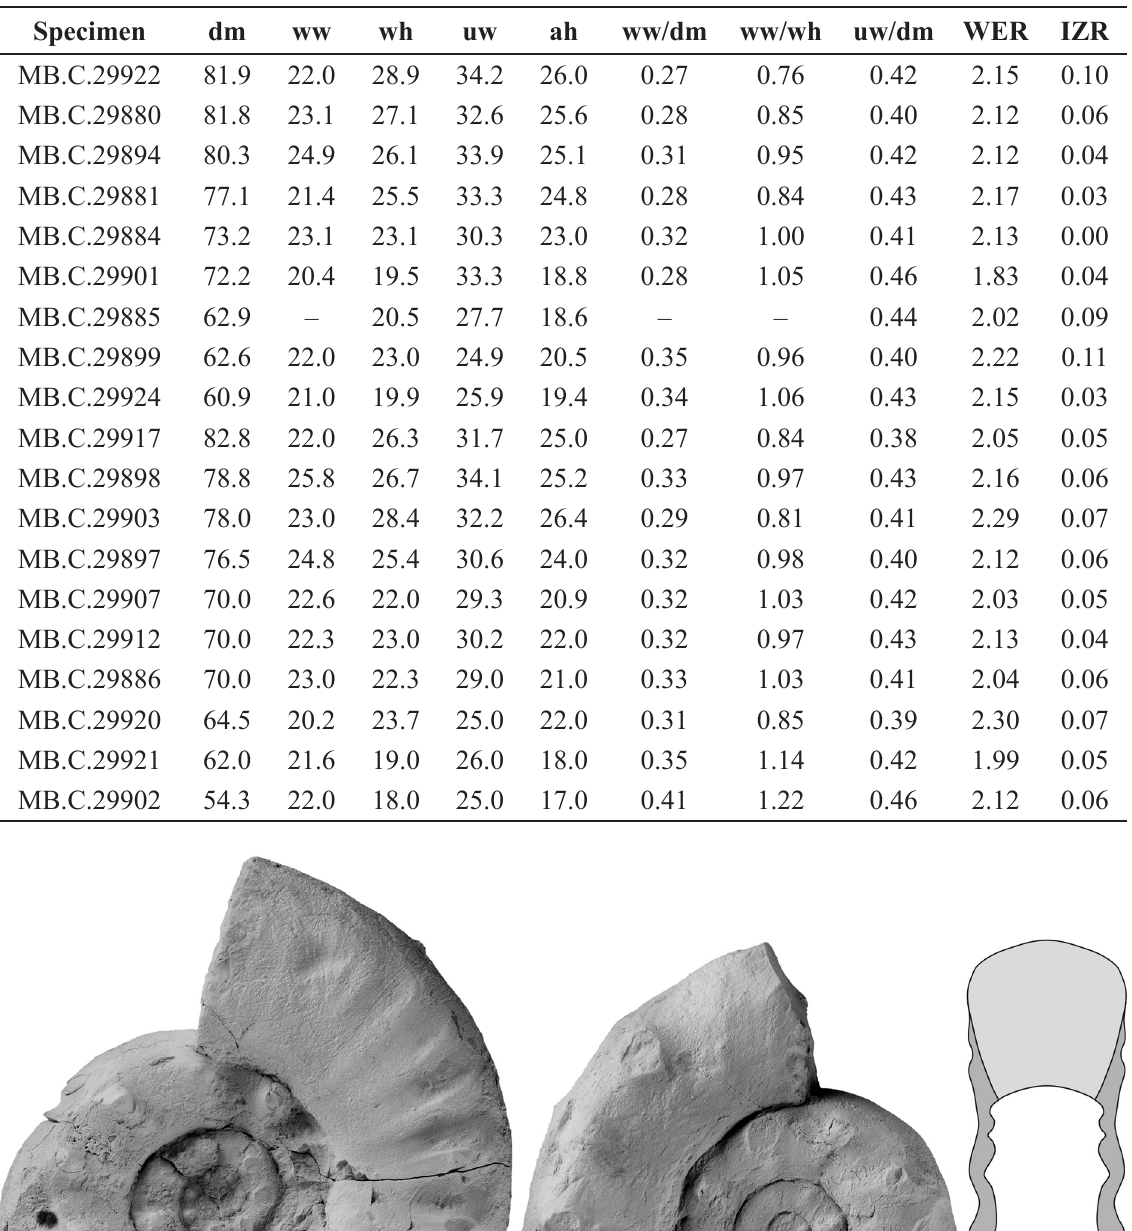
Table 17. Conch dimensions (partly estimated) and ratios of selected specimens of Paratirolites aduncus Korn & Hairapetian sp. nov. from Baghuk Mountain.